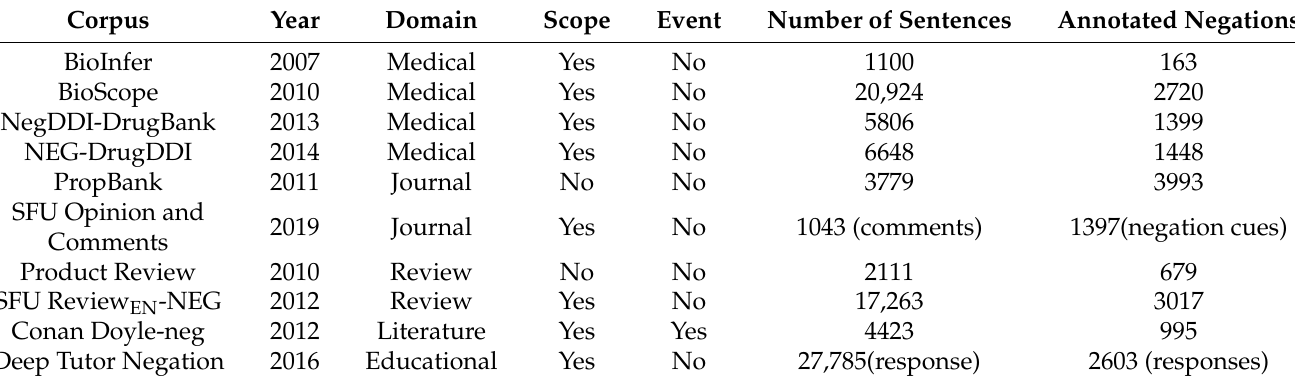
Table 1. English corpora annotated with